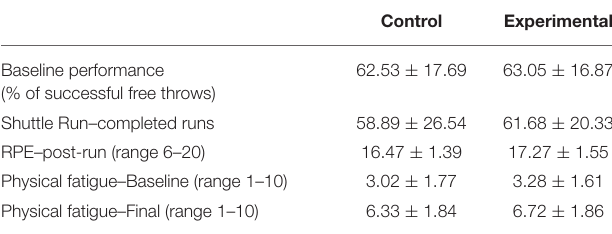
TABLE 1 | Descriptive statistics for control measures and manipulation checks.